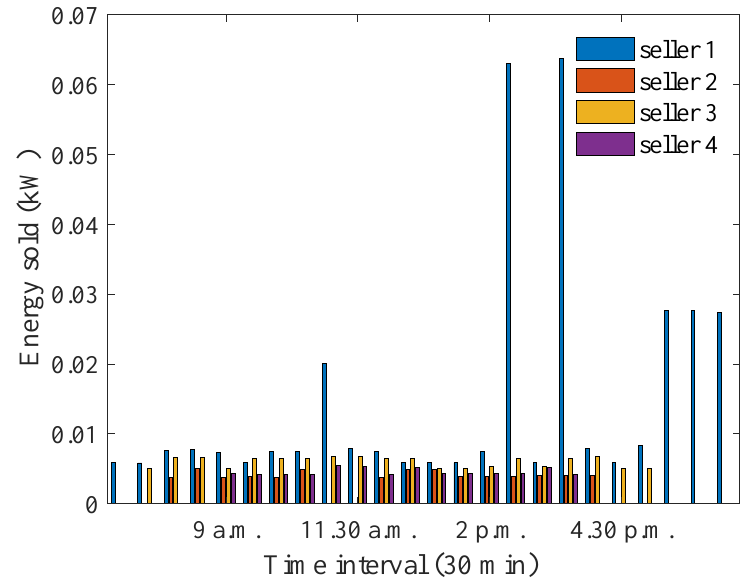
Figure 9. Optimum energy sold for sellers during summer months.